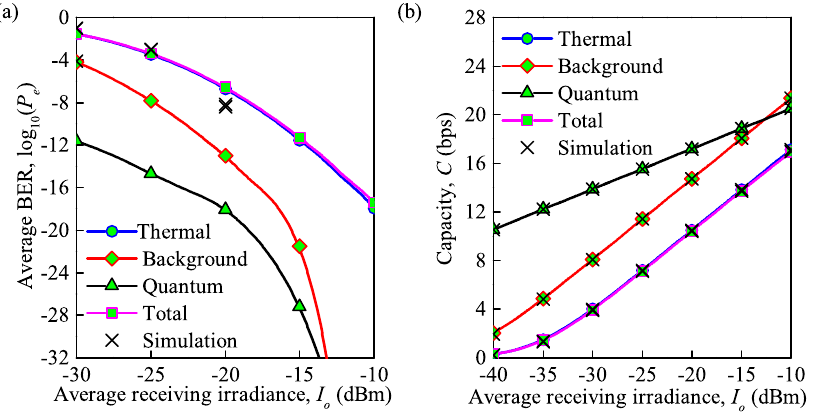
Figure 5. ( a ) Average BER versus average irradiance received under different types of noise; ( b ) average capacity versus average irradiance received under different types of noise ( C 2 n = 0.35 × 10 − 14 m − 2/3 for weak turbulence, λ = 850 nm, R b = 0.155